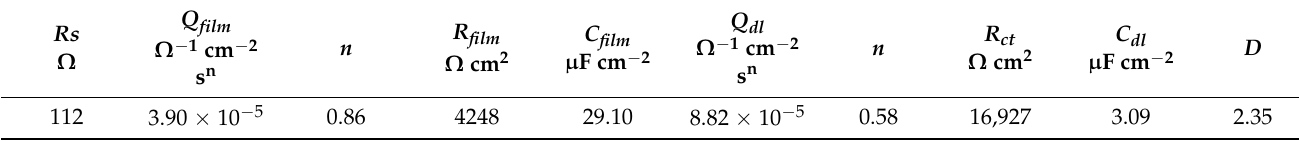
Table 2. CPE parameters ( Q and n ), resistance, effective capacitance, and fractal dimension of API X60 steel in 3.5% w / v NaCl solution, at pH = 5.0, in the presence of 0.2% by weight of MSNs-Caf-PbAE as corrosion